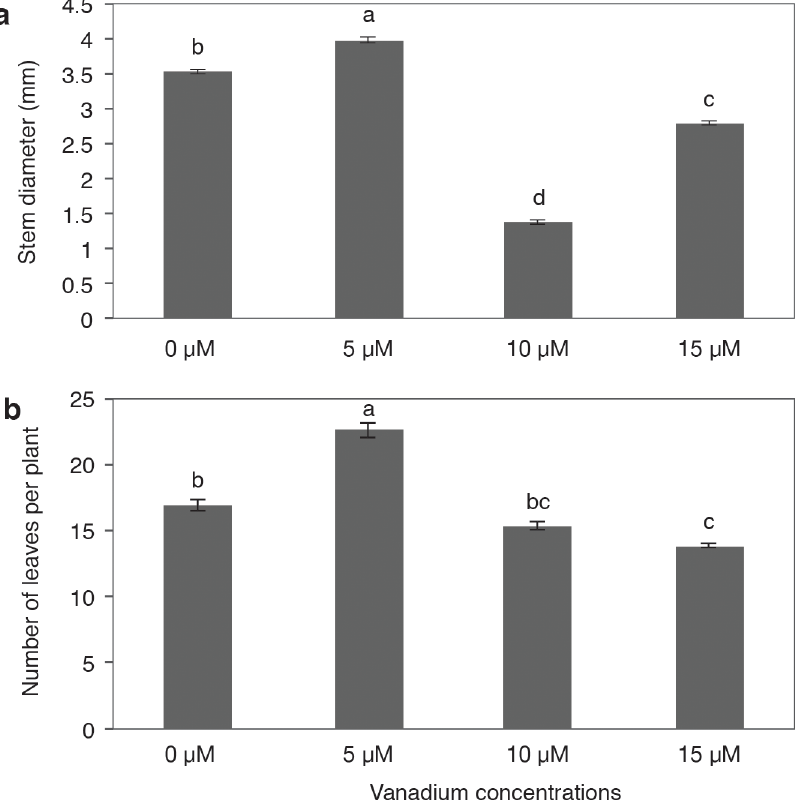
Fig 3. Stem diameter (a) and number of leaves (b) of pepper plants grown in nutrient solutions containing different concentrations of vanadium (0, 5, 10 and 15 μ M V) during 28 d. Values are means ± standard error (SE) from at least five individual plants. Different letters above the bars indicate significant differences (Duncan, α = 0.05).